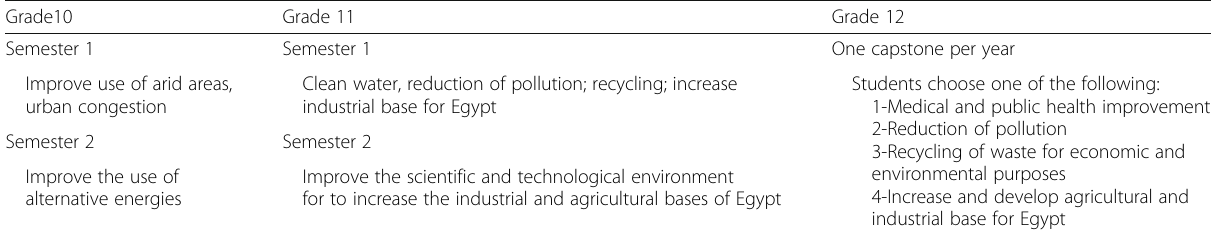
Table 5 Capstones per year per semester aligned with grand challenges a